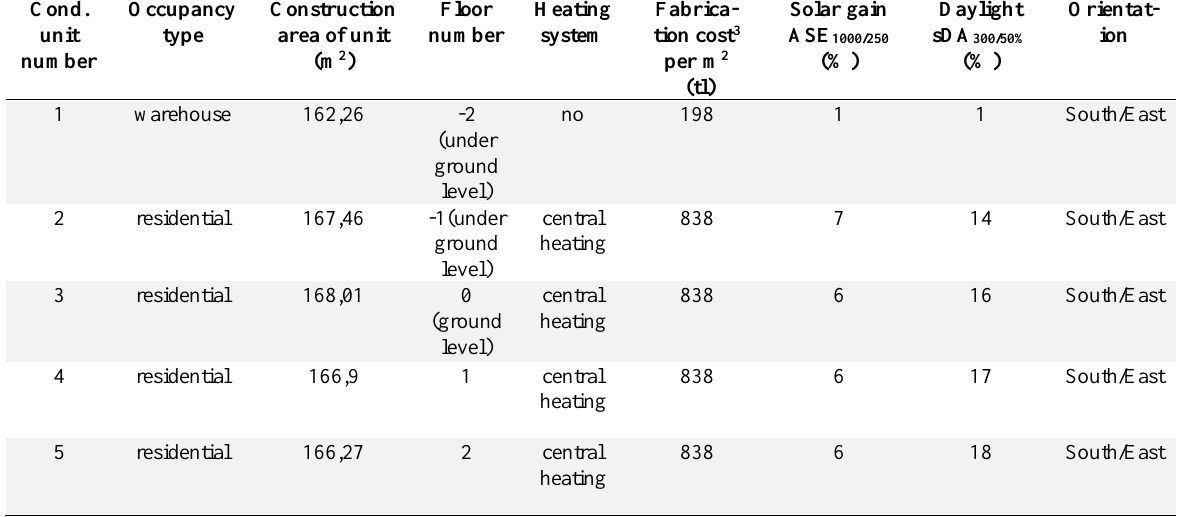
Table 2. Land share factors and their analysis results obtained from the BIM model ASE measures the percentage of floor area that receives at least 1000 lux for at least 250 occupied hours per year (Sterner, 2014) and measures the presence of sunlight using annual hourly horizontal illuminance grids (Wymelenberg and Mahić, 2016). So the metric was used for determining the solar gains of each condominium unit. floor area of the each condominium unit exceeded the